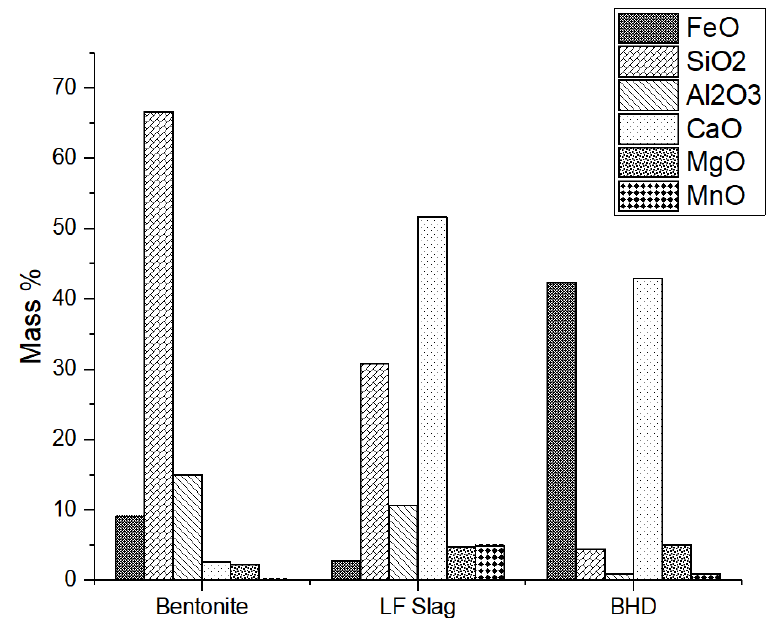
Figure 1. Chemical composition of bentonite and Ladle Furnace (LF) slag, Bag house dust (BHD) and Cyclone.